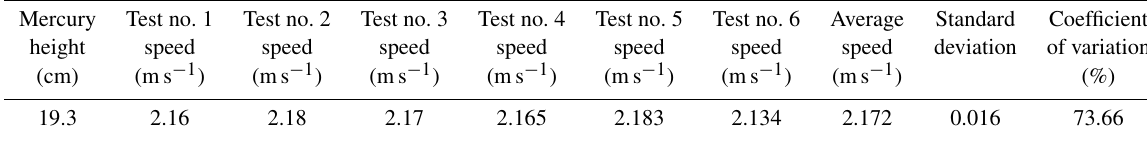
Table 2. The standard deviation calculation of speed data in the test section.